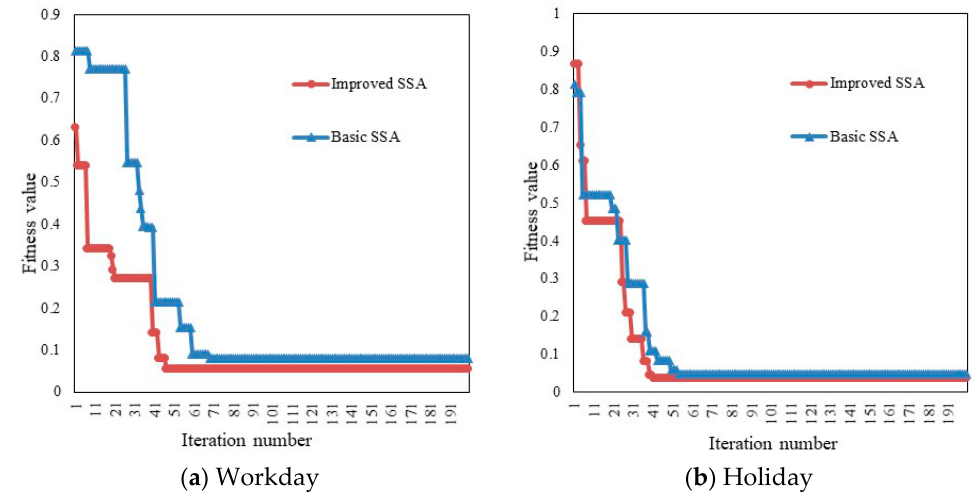
Figure 10. The convergence trend of the ISSA and the basic SSA.